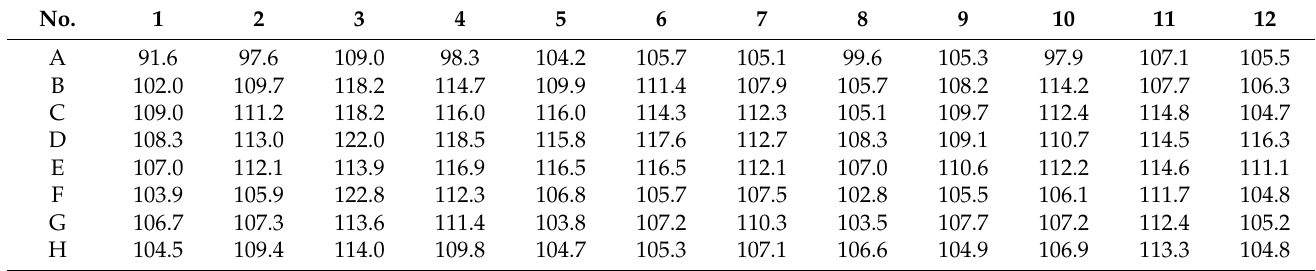
Table 10. Cell viability